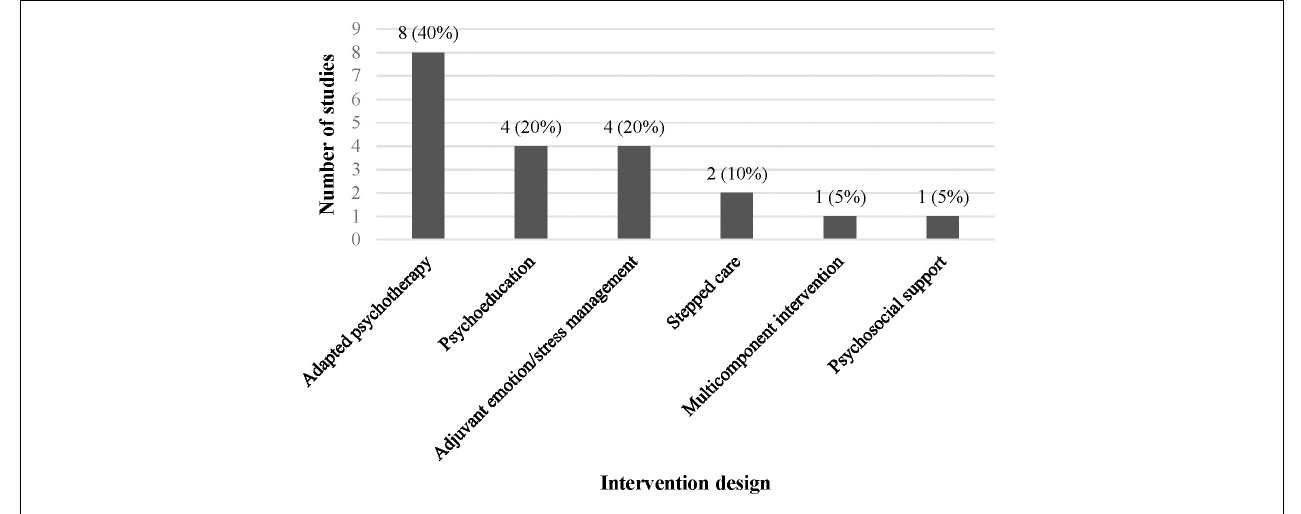
FIGURE 2 | Number and percent of studies by intervention